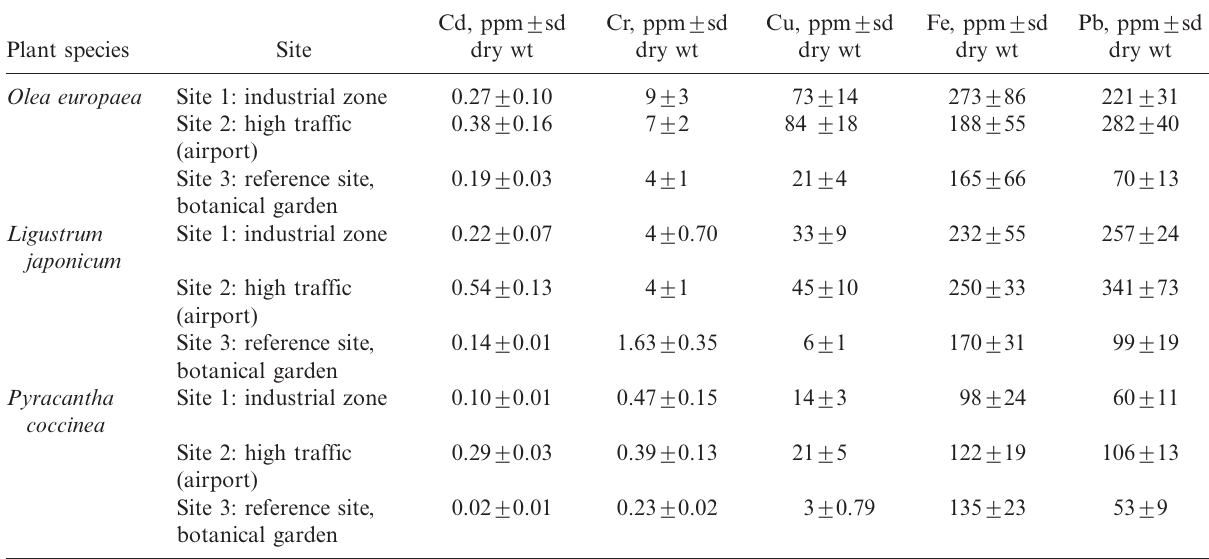
Table 1. Comparison of Cd, Cr, Cu, Fe, and Pb concentrations in leaves of Olea europaea , Ligustrum japonicum, and Pyracantha coccinea from different studied sites Cd, ppm 9 sd Plant species Site Olea